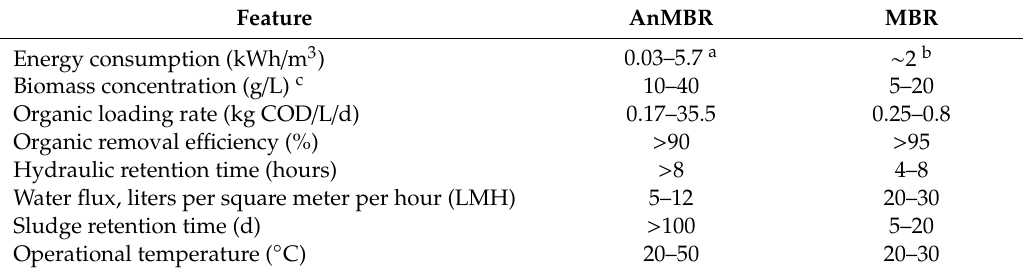
Table 2. Comparison between anaerobic membrane bioreactors (AnMBRs) and MBRs for wastewater treatment (Adapted from [81]). Copyright Bioresource Technology,